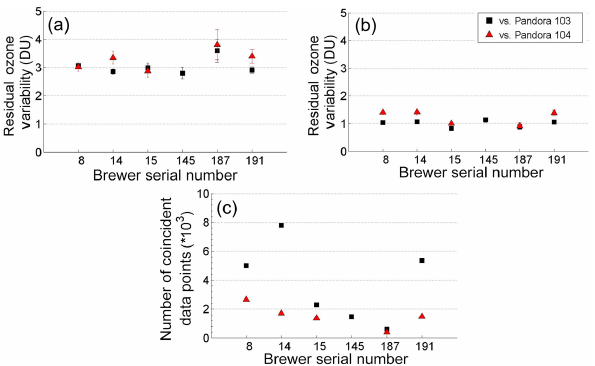
Figure 3. Estimated residual ozone variability ( σ X ) using (a) resid- ual ozone type 1 and (b) residual ozone type 2. (c) Number of coin- cident measurements used in the statistical uncertainty estimation. The black squares indicate data from Pandora no. 103, and the red triangles indicate data from Pandora no. 104. The error bars show the 95% confidence bounds.